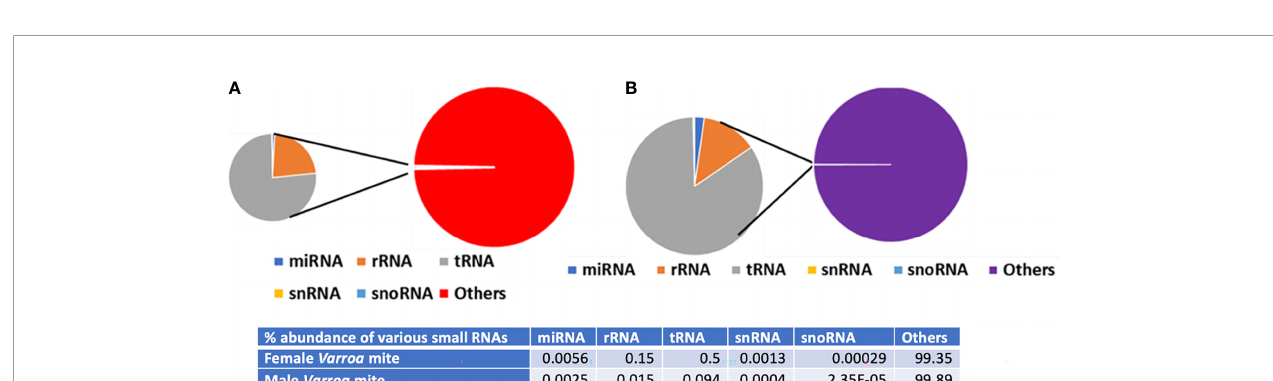
FIGURE 5 | Summary of Varroa -derived female (A) and male (B) small RNA reads matching various small RNA categories.